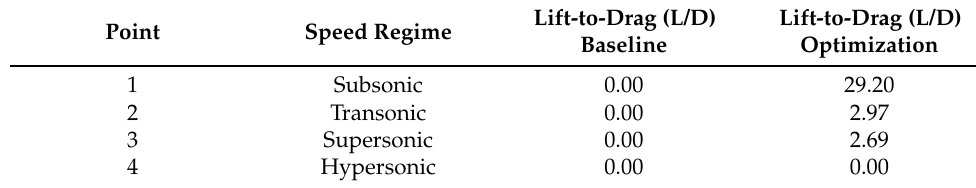
Table 4. Lift-to-drag ratio results.